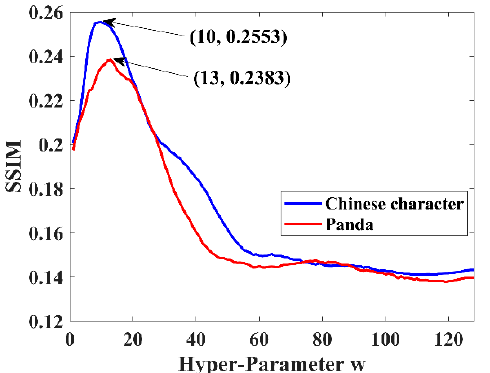
Figure 10. The curves of SSIM changing with the hyper-parameter w .